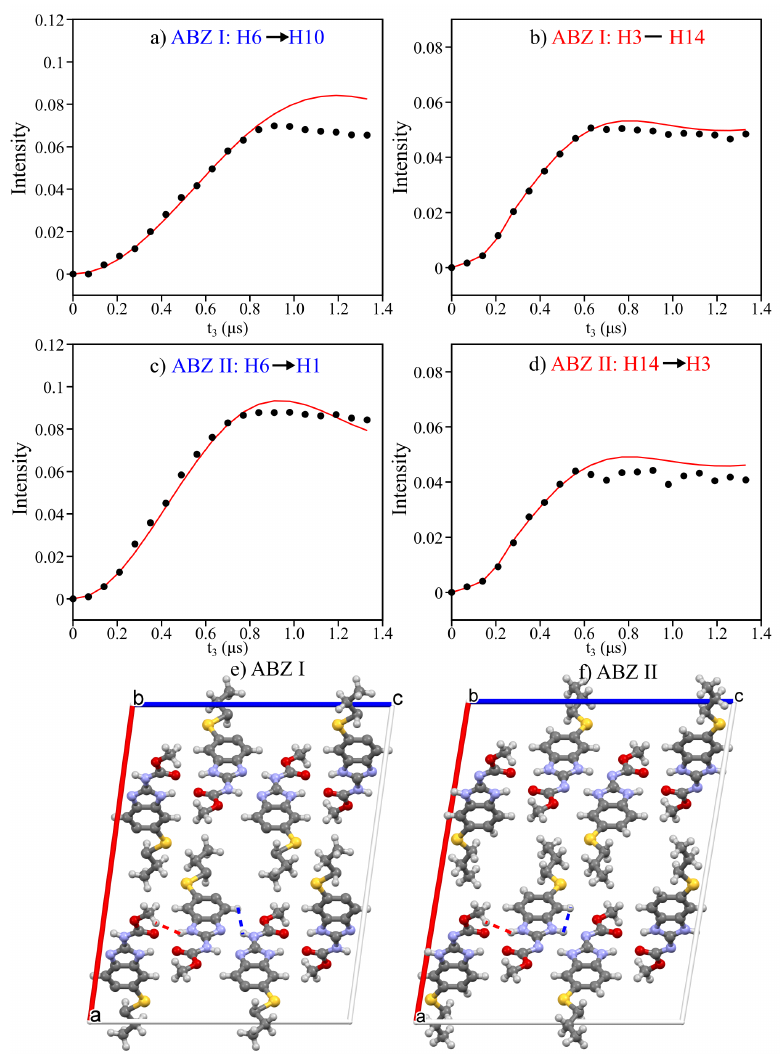
Figure 7. Polarisation transfer from: ( a ) H6 to H10 for ABZ I; ( b ) H3 to H14 for ABZ I; ( c ) H6 to H1 for ABZ II; and ( d ) H3 to H14 for ABZ II. Scheme showing the measured distances in: ( e ) ABZ I; and ( f ) ABZ